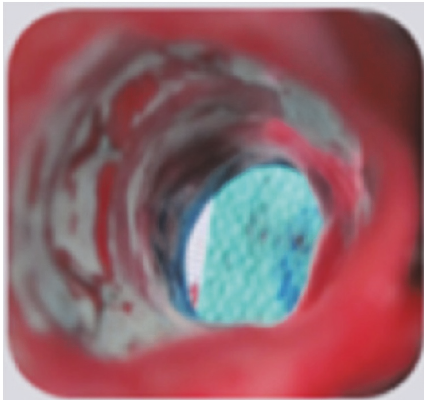
Figure4:IVCfromananimalfromtheearly-incorporationanalysis cohort terminated at 97 days. Laparoscopic imaging at necropsy of IVC sections containing the Sentry IVC filter, showing the unobstructed patent lumen and the nearly complete incorporation of the filter